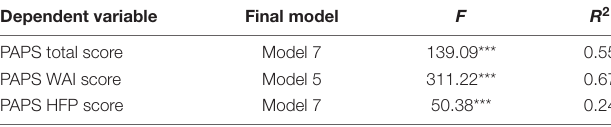
TABLE 4 | Multiple hierarchical regression: overall model